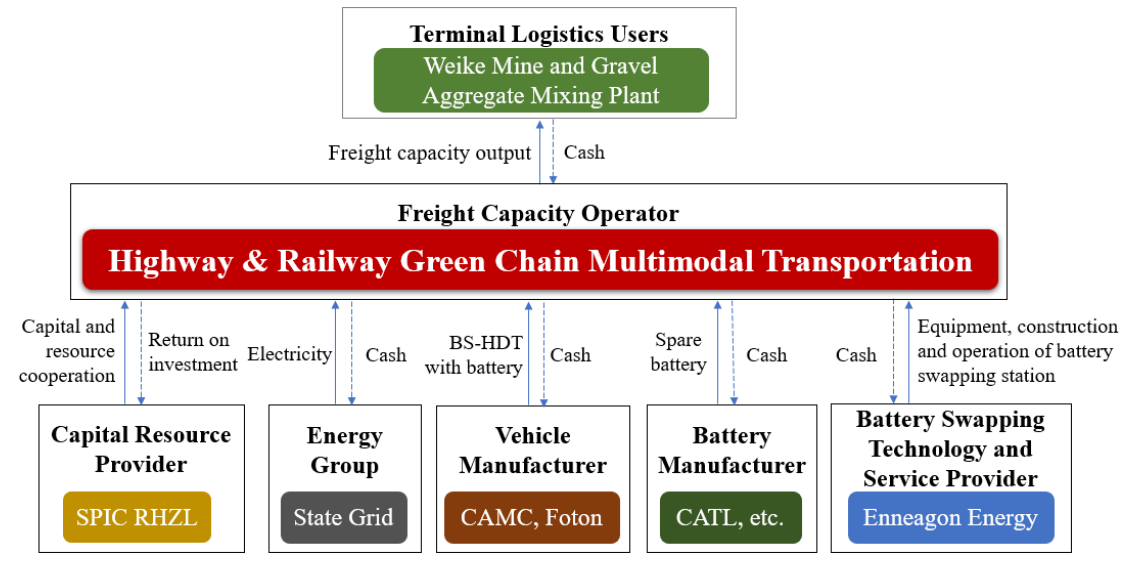
Figure 3. Schematic diagram of BS-HDT operation cooperation mode in the “Beijing Case”.